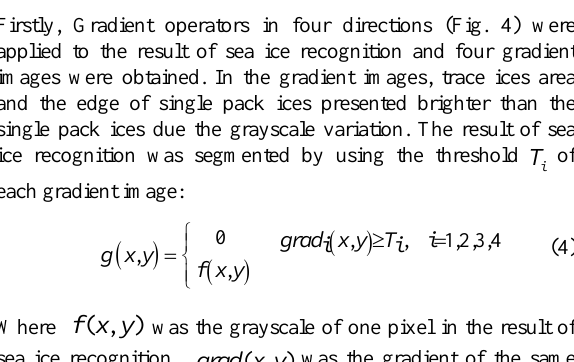
Fig.3 Single pack ices and trash ices in a part of the enlarged result of sea ice recognition.